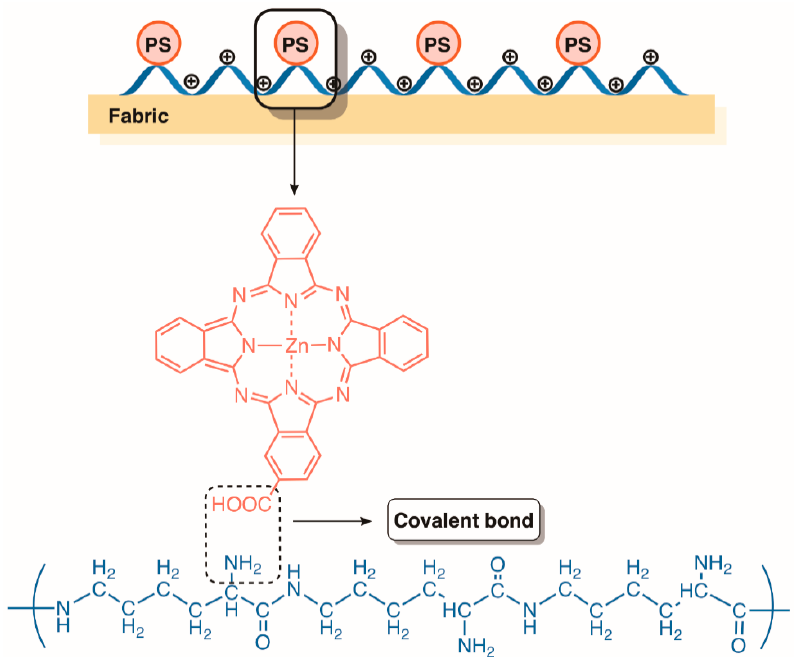
Figure 28. Design strategy of PS- ε -polylysine-fabric material with dual antimicrobial mechanisms (adapted from Reference [137]).